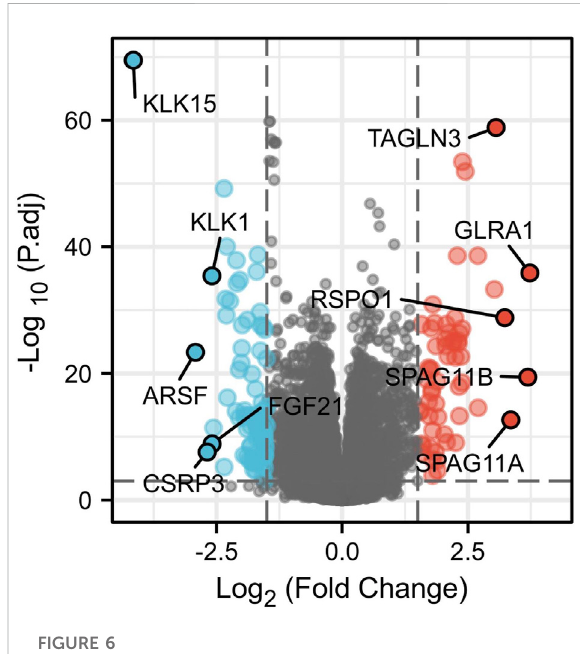
FIGURE 6 Volcano plot of differentially expressed genes (DEGs) between high and low ERBB2 expression groups. The signi fi cantly up-regulated genes are red dots; the signi fi cantly down-regulated genes are blue dots. The dots marked with gene names are the most up-regulated fi ve DEGs and the most down-regulated fi ve